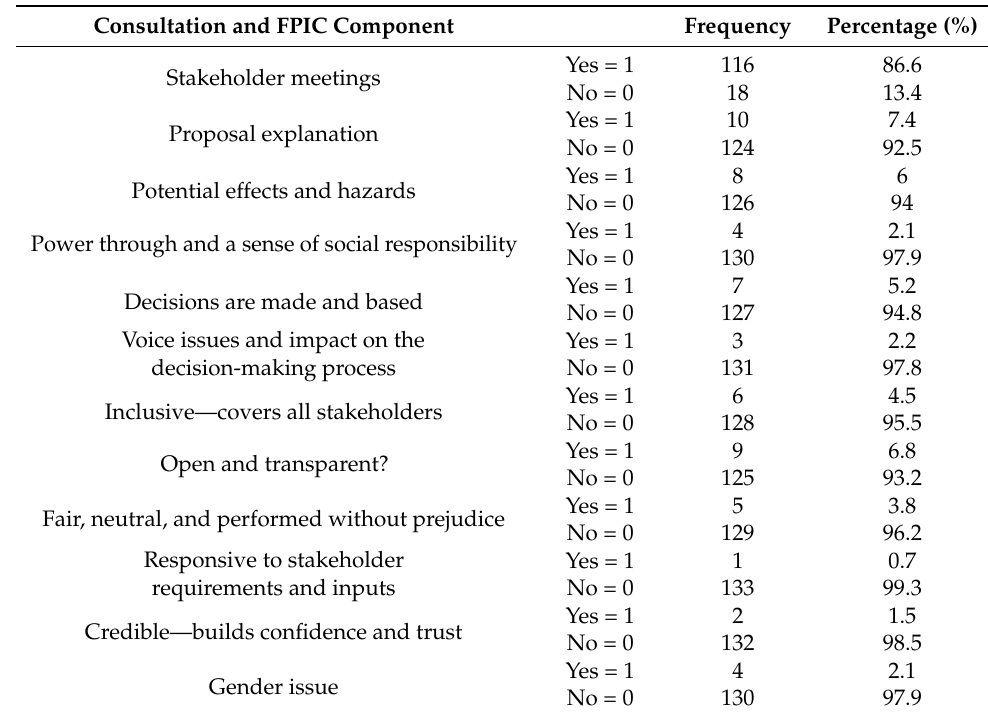
Table 2. Involvement during the consultation application of FPIC or two-way exchange of information ( n = 134 ).